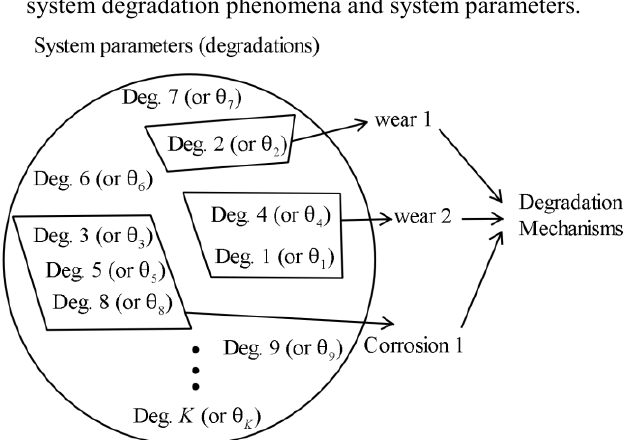
Figure 4. Illustration of system parameters and well-known degradation